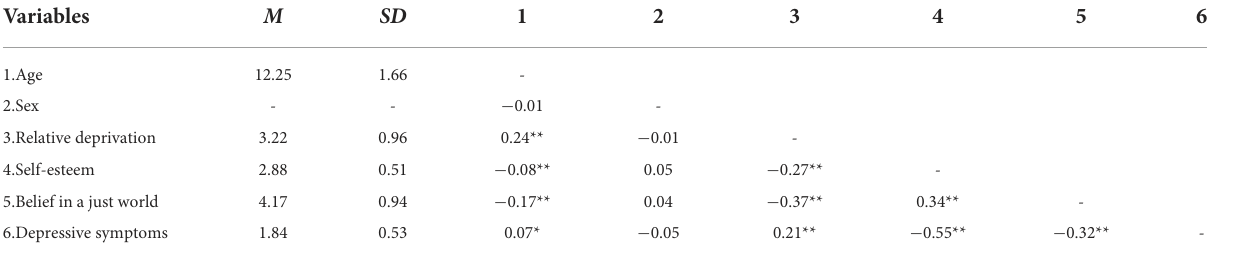
TABLE 2 Descriptive statistics and correlations among key variables.